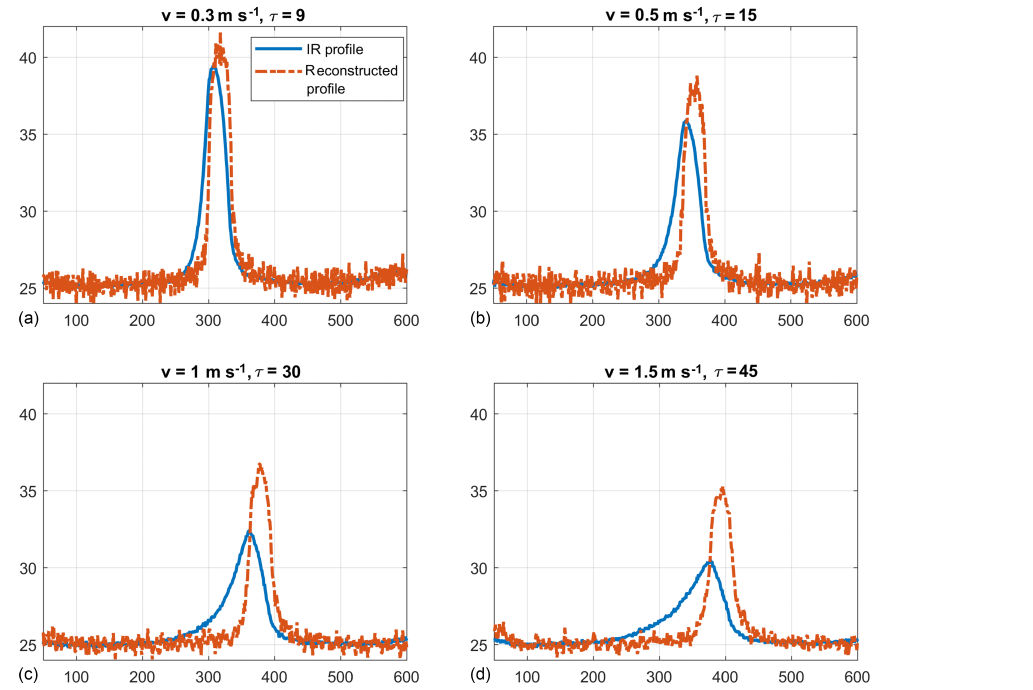
Figure 3. Temperature profiles through the blurred and the reconstructed images of Fig. 2. The corresponding data are summarized in Table 1. Table 1. Data of the four measurements in Figs. 2 and 3 are summarized in the table. For the reconstruction, k = 0 . 005 has been used. The resolution was r = 3 pixelmm − 1 and d =